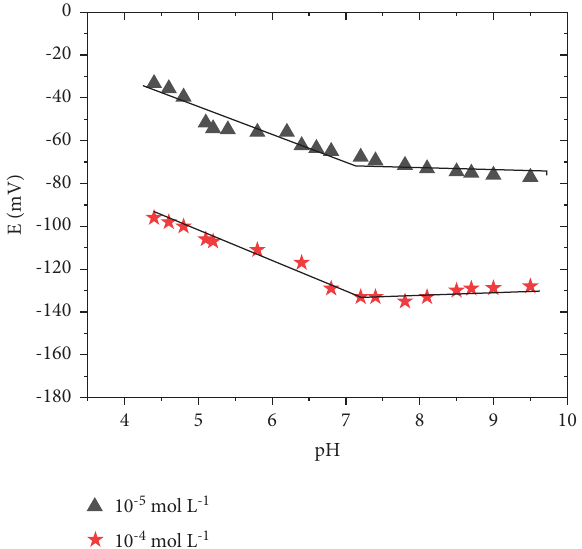
Figure 6: Te efect of pH on the potentiometric response of the terbinafne microchip.